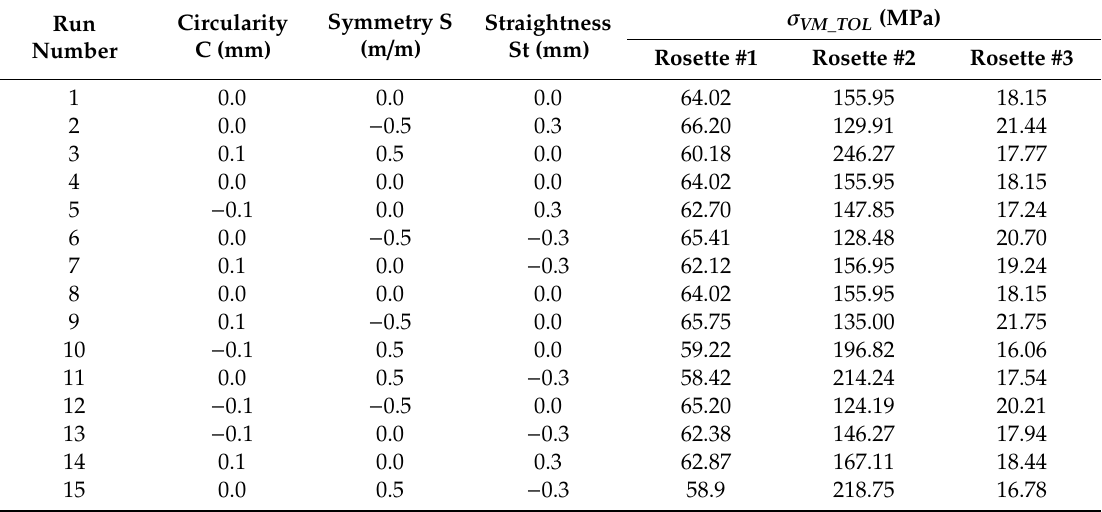
Summary of the simulations results based in the Box–Behnken design of the geometric